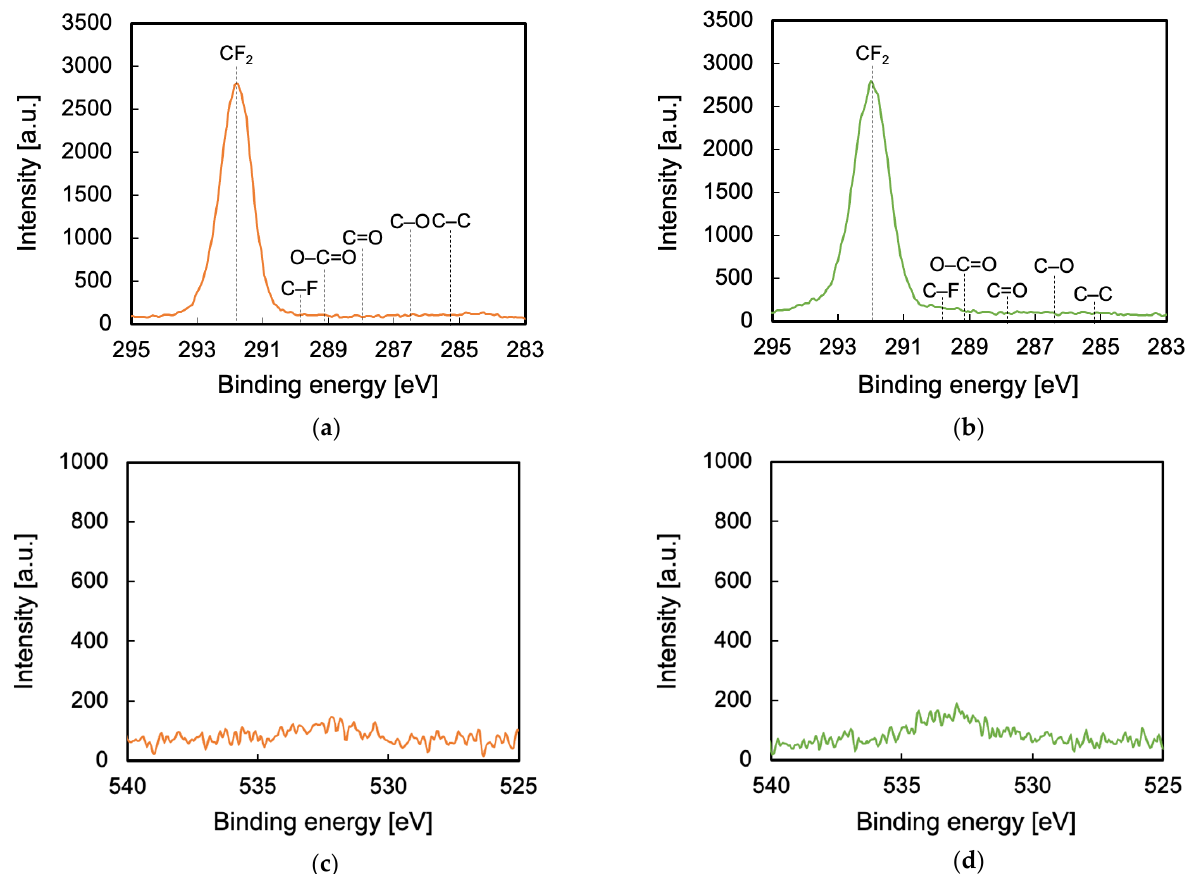
Figure 10. XPS spectra of the plasma-treated PTFE samples covered with an MgF 2 substrate and without using a heater. ( a ) C1s-XPS of the He plasma-treated PTFE, ( b ) C1s-XPS of the Ar plasma-treated PTFE, ( c ) O1s-XPS of the He plasma-treated PTFE, and ( d ) O1s-XPS of the Ar plasma-treated PTFE.